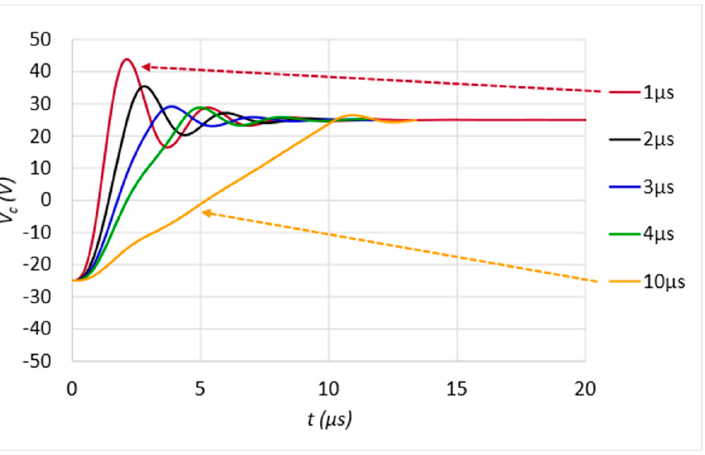
Figure 9. Simulated transient voltage waveforms on the capacitor element for slip times of 1, 2, 3, 4 and 10 µs.